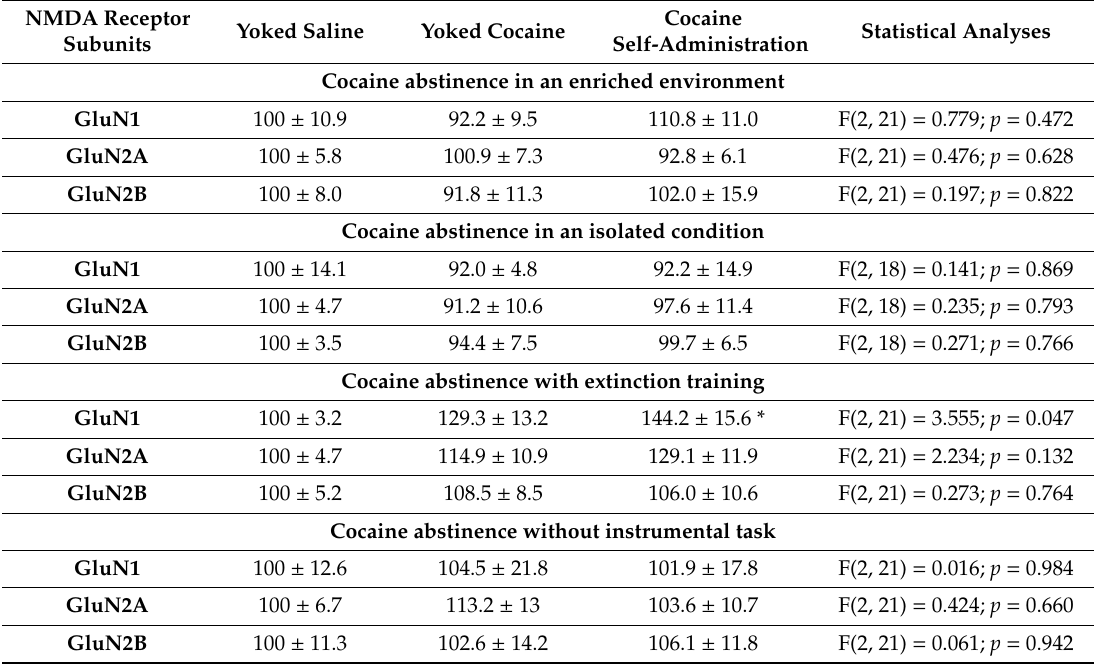
Table 2. Changes in the expression of NMDA receptor subunits (GluN1, GluN2A and GluN2B) in the nucleus accumbens in rats following different conditions of cocaine forced abstinence. NMDA